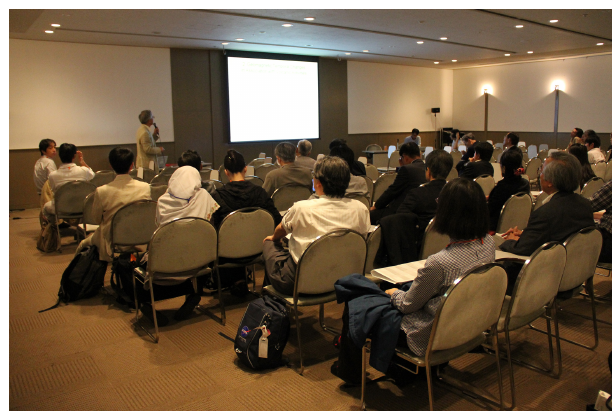
Figure 31. A special session, “100 years of geomagnetic obser- vations at Kakioka – contributions to centennial progress of geo- physics”, at the annual meeting of the Japan Geoscience Union on 24 May at Makuhari, Chiba (photo supplied by Kakioka Magnetic